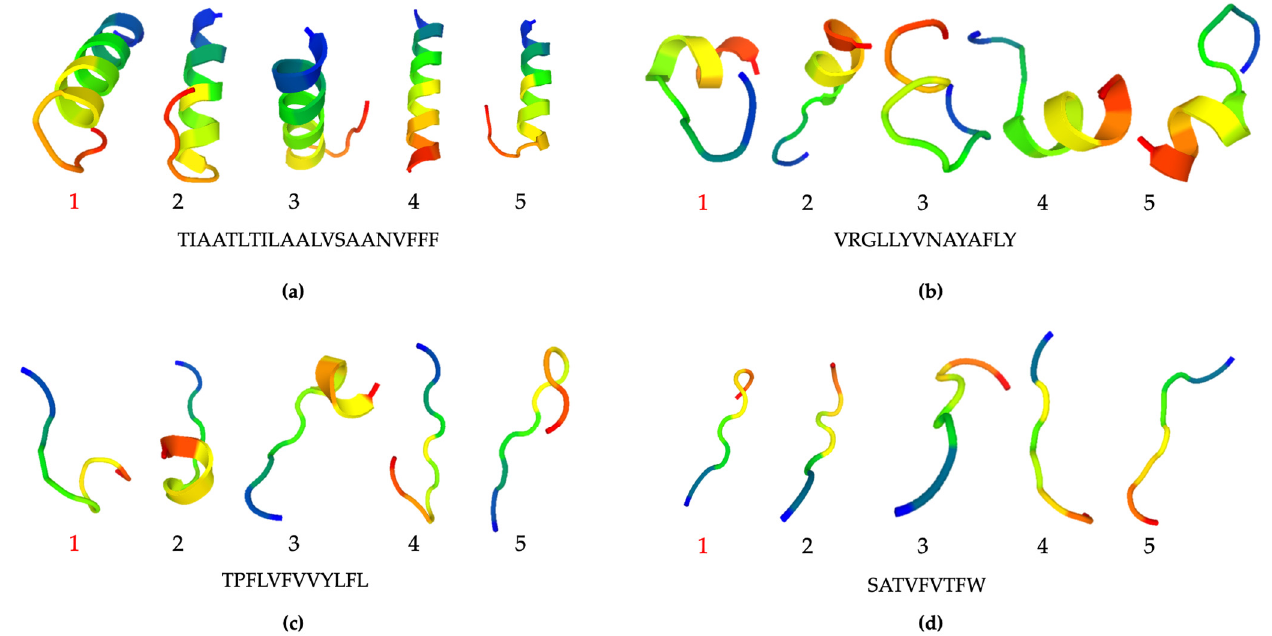
Figure 8. Best five models (representatives of five best clusters) of peptide structure prediction using PEP-FOLD according to the clustering reports: nonanal- grand-average-of-hydropathicity-binding peptide ( a ); benzaldehyde-binding peptide ( b ); acetone-binding peptide ( c ); ethanol-binding peptide ( d ).